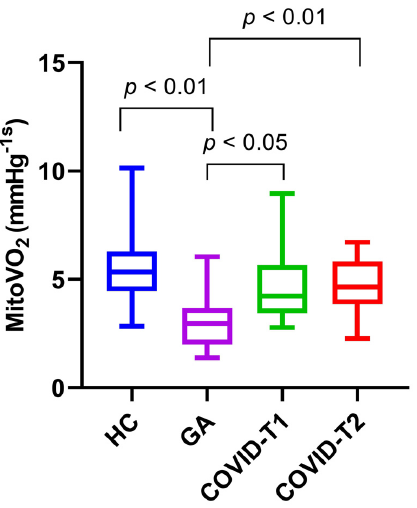
Figure 3. MitoVO 2 (mmHg/s) in HC, COVID-19 patients on T1 and T2, and the general anesthesia group. HC = healthy controls, T1 = time point 1, T2 = time point 2, and GA = general anesthesia. Values are displayed as median with interquartile range (box) and minimum and maximum (whisk- ers).